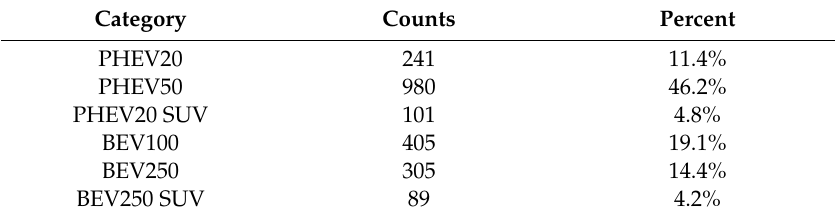
Table 1. Number and percent share of registered Wisconsin PEVs by vehicle category [data from